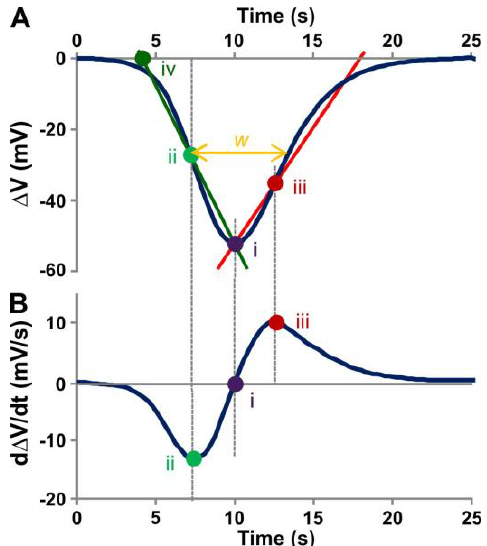
Figure 2. Analysis of action potentials. APs were recorded relative to the baseline, converted to a Microsoft excel file and imported into SigmaPlot (Version 11; Systat Software, San Jose, CA, USA). ( A ) For analyses, data were smoothed by calculating the running average over four neighbouring points using the “2 D smoothing function”. ( B ) dΔ V /d t values were then obtained using the “Compute 1st Derivative” function. To elaborate standardised characteristic parameters, an AP was approximated by a triangle shape (green and red lines). For this, the peak of the AP (Point i) as well as the reversal Points ii and iii (d ΔV /d t = 0), were determined. The intersection of the linear regression between Points i and ii with the time axis determined the start point of the AP (Point iv). The AP signal width (w) was measured as the change in time (Δ t ) at the half-maximum AP amplitude. The propagation speed of the signal was taken from the measured distance between the two recording electrodes at E1 and E2, divided by the time in seconds between the two start points (Point iv) at E1 and E2. Table 1. Numerical data for action potentials (APs) recorded in electrically-stimulated wildtype and gork knockout mutants of WS and Col-0 ecotypes. gork knockout mutants were compared to their respective wildtype (WT). Excitability was taken as the number of plants (of the 100 tested) displaying an AP after electrical stimulation. For other data, 25 plants displaying typical APs were used (Means ± SD). Because APs dramatically increased upon propagation in gork knockout mutants, signals recorded by both E1 and E2 were considered separately for amplitude and width statistics. Speed of propagation was the distance between E1 and E2 divided by the time-shift between APs recorded at these electrodes.